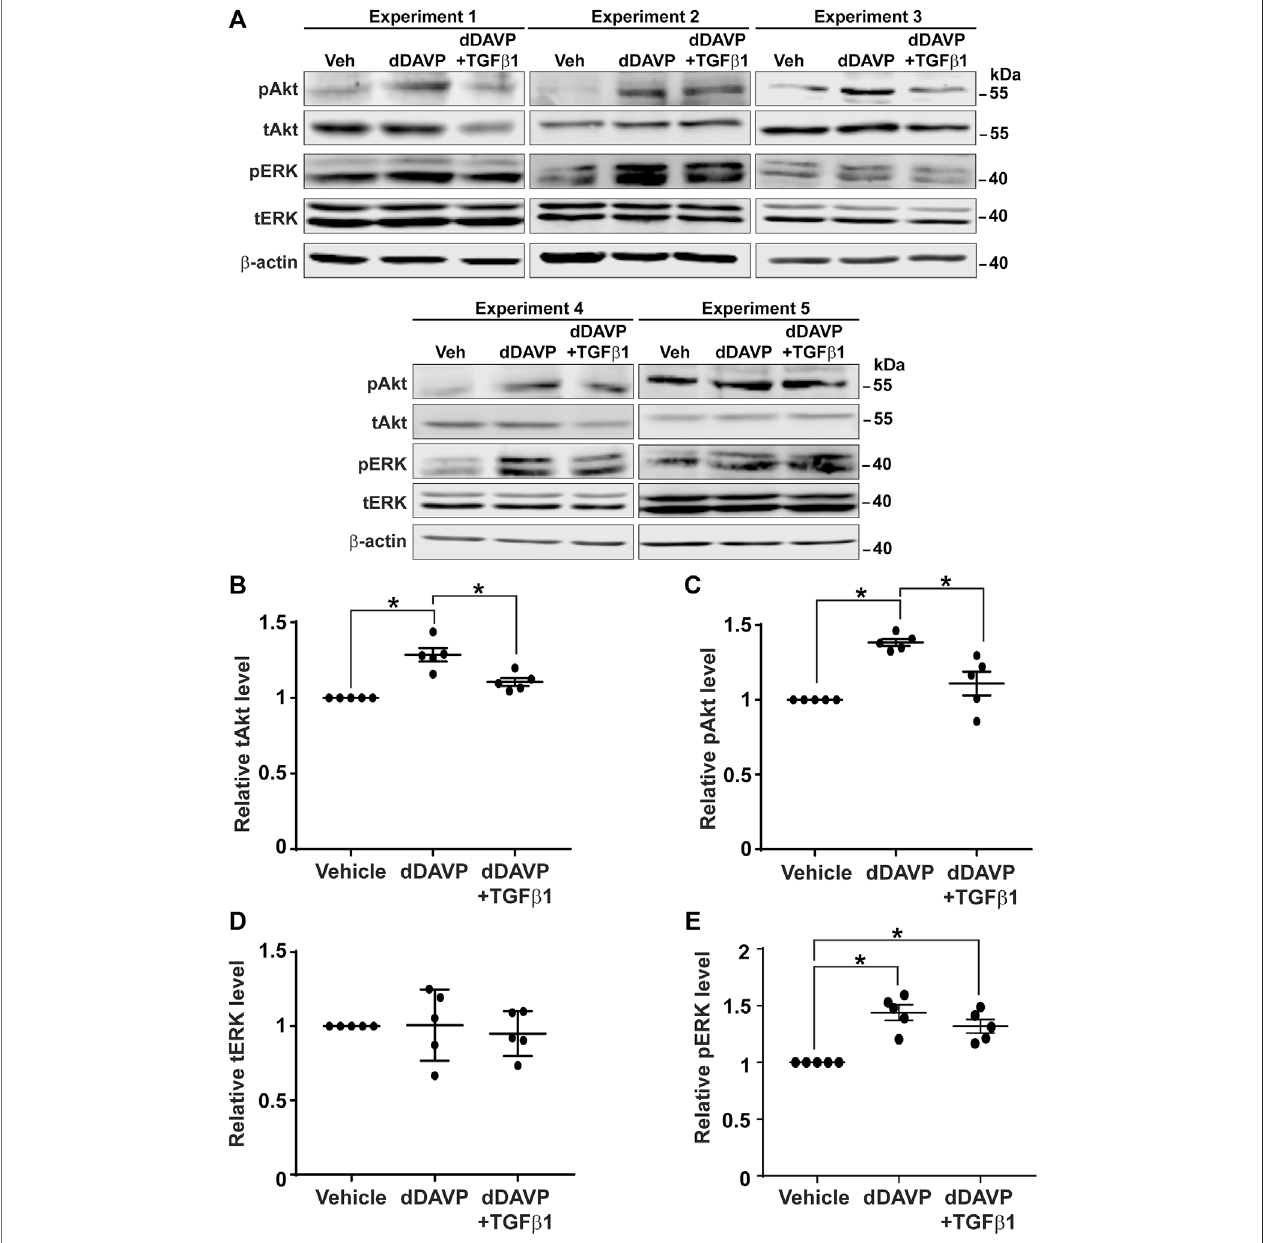
FIGURE 8 | TGF β 1 reduced vasopressin-induced Akt activation. (A) Immunoblots for total and phosphorylated Akt and Erk in the mpkCCD cells in response to vehicle vs. dDAVP (1 nM, 24 h) in the absence or presence of TGF β 1 (10 ng/ml). (B – E) Summary of the immunoblotting results. Values are mean ± S. E. summarized from fi ve independent experiments. Values were normalized with loading control ( β -actin) before being compared against those under the vehicle conditions. Asterisks indicate statistical signi fi cance ( p < 0.05, t -test). pAkt, phosphorylated Akt; pErk, phosphorylated Erk; tAkt, total Akt; tErk, total Erk.